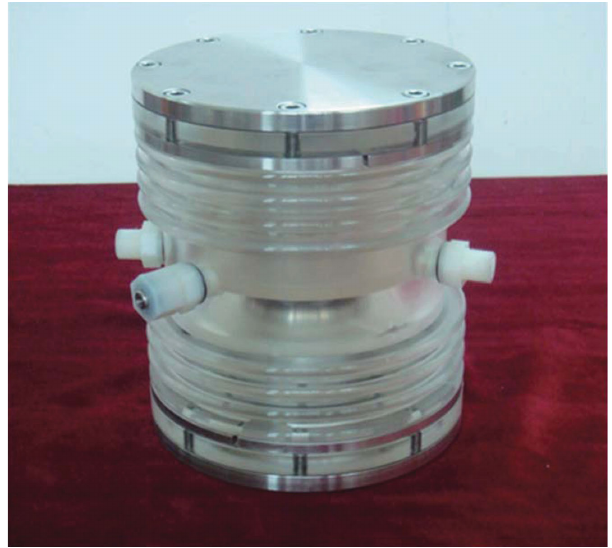
FIG. 14. Photo of the type 4 switch used in M-50. It has four gaps and a total gap length of 30 mm. Dry air is used as insulation